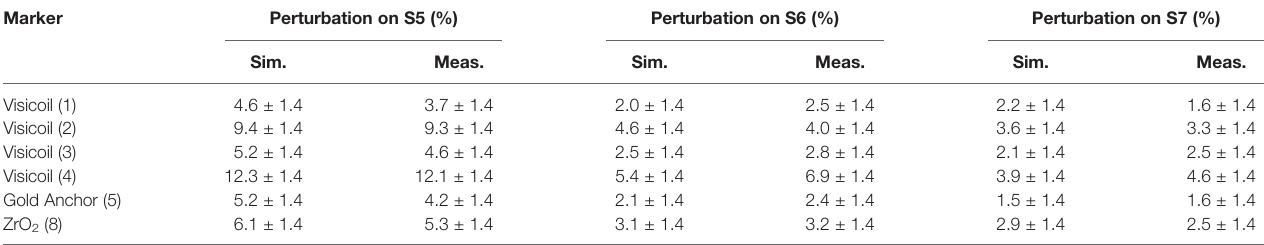
TABLE 9 | Comparison of the fl uence perturbation values at several positions (sensor 5, sensor 6, and sensor 7) between the FLUKA simulations (Sim.) and the CMOS measurements (Meas.) for the different fi ducial markers for the 169MeV proton beam. Marker Perturbation on S5 (%) Perturbation on S6 (%)